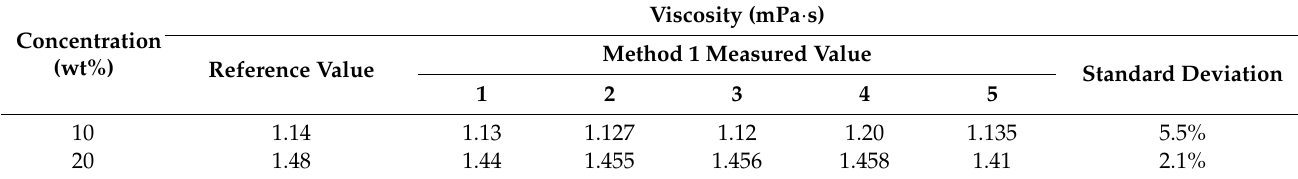
Table 3. Measured the blood viscosity by oscillating circuit analysis